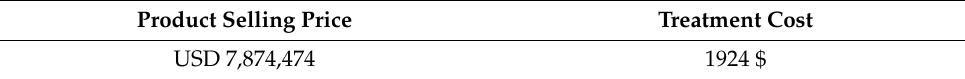
Table 11. Parameters that affect